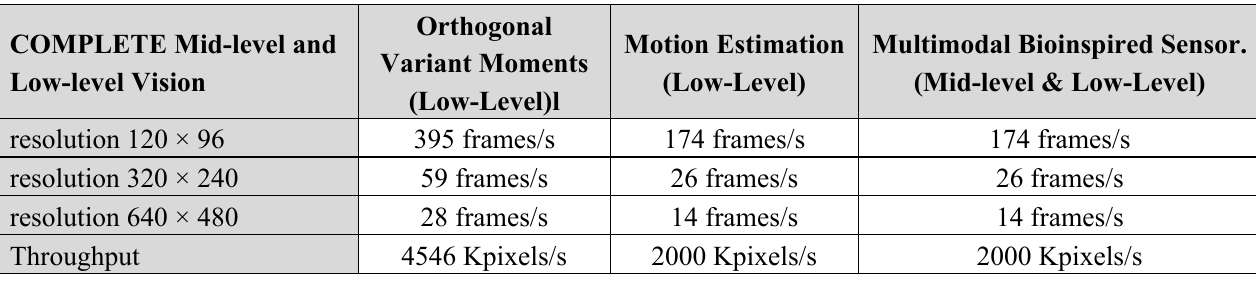
Table 4 . Throughput in terms of Kpps and frames/second for the embedded